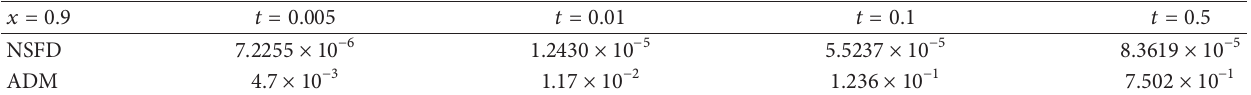
Table 3: The absolute errors of NSFD method and ADM (𝑛 = 4) for (52) at 𝑥 = 0.9 . 𝑥 = 0.9 𝑡 =